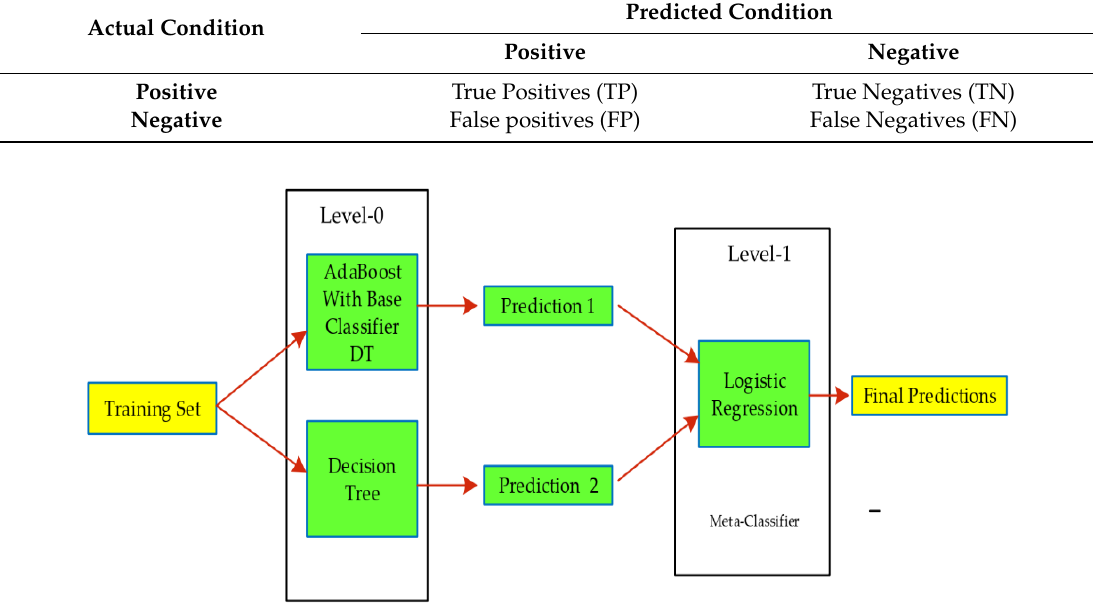
Table 2. Confusion matrix for evaluating model’s performance.